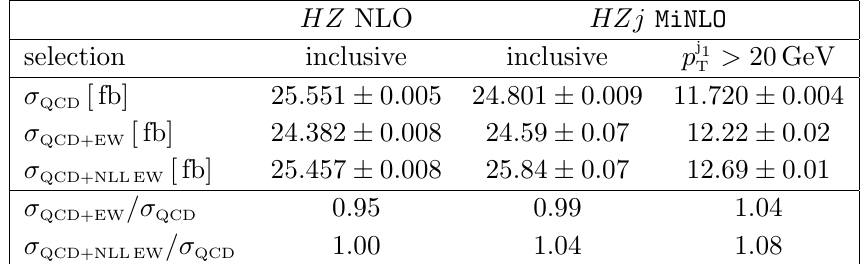
Table 2. NLO total cross sections for HZ (second column) and HZj (third and fourth column) production at a center-of-mass energy of p s = 13 TeV. Predictions and labels as in table 1.